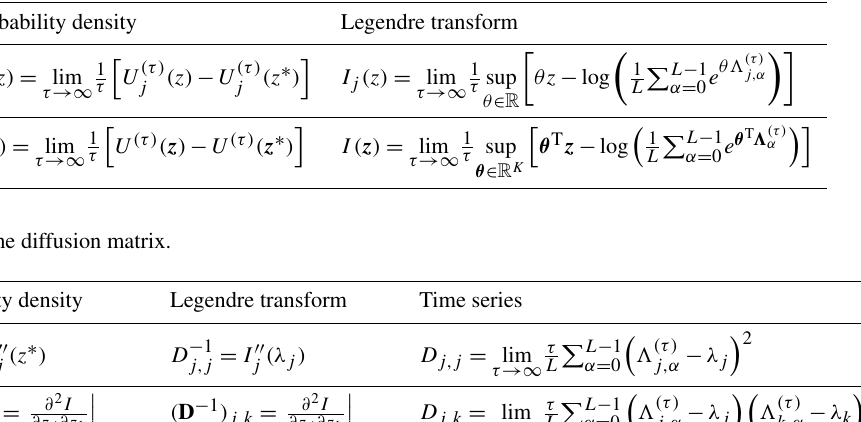
Table 4. Methods for estimating the rate function.